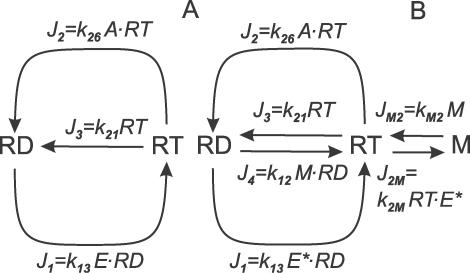
Flux Diagrams for the Reduced Models of GEF–GAP (A) and M–GAP (B) ModulesActivation of RD by the GEF or by the GEF-effector complex (E*) is denoted as J
1. Inactivation of RT by the GAP and its spontaneous hydrolysis are represented by fluxes J
2 and J
3, correspondingly. Activation of RD by M is represented by J
4 in (B).